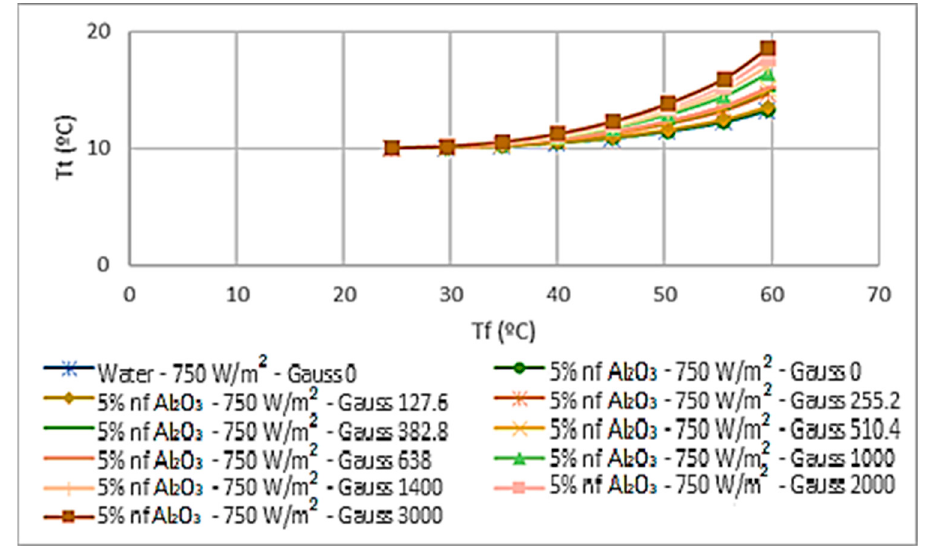
Figure 15. The temperature profile in the storage tank induced by PV-Th solar panels with different magnetic fields and nanofluid temperatures.